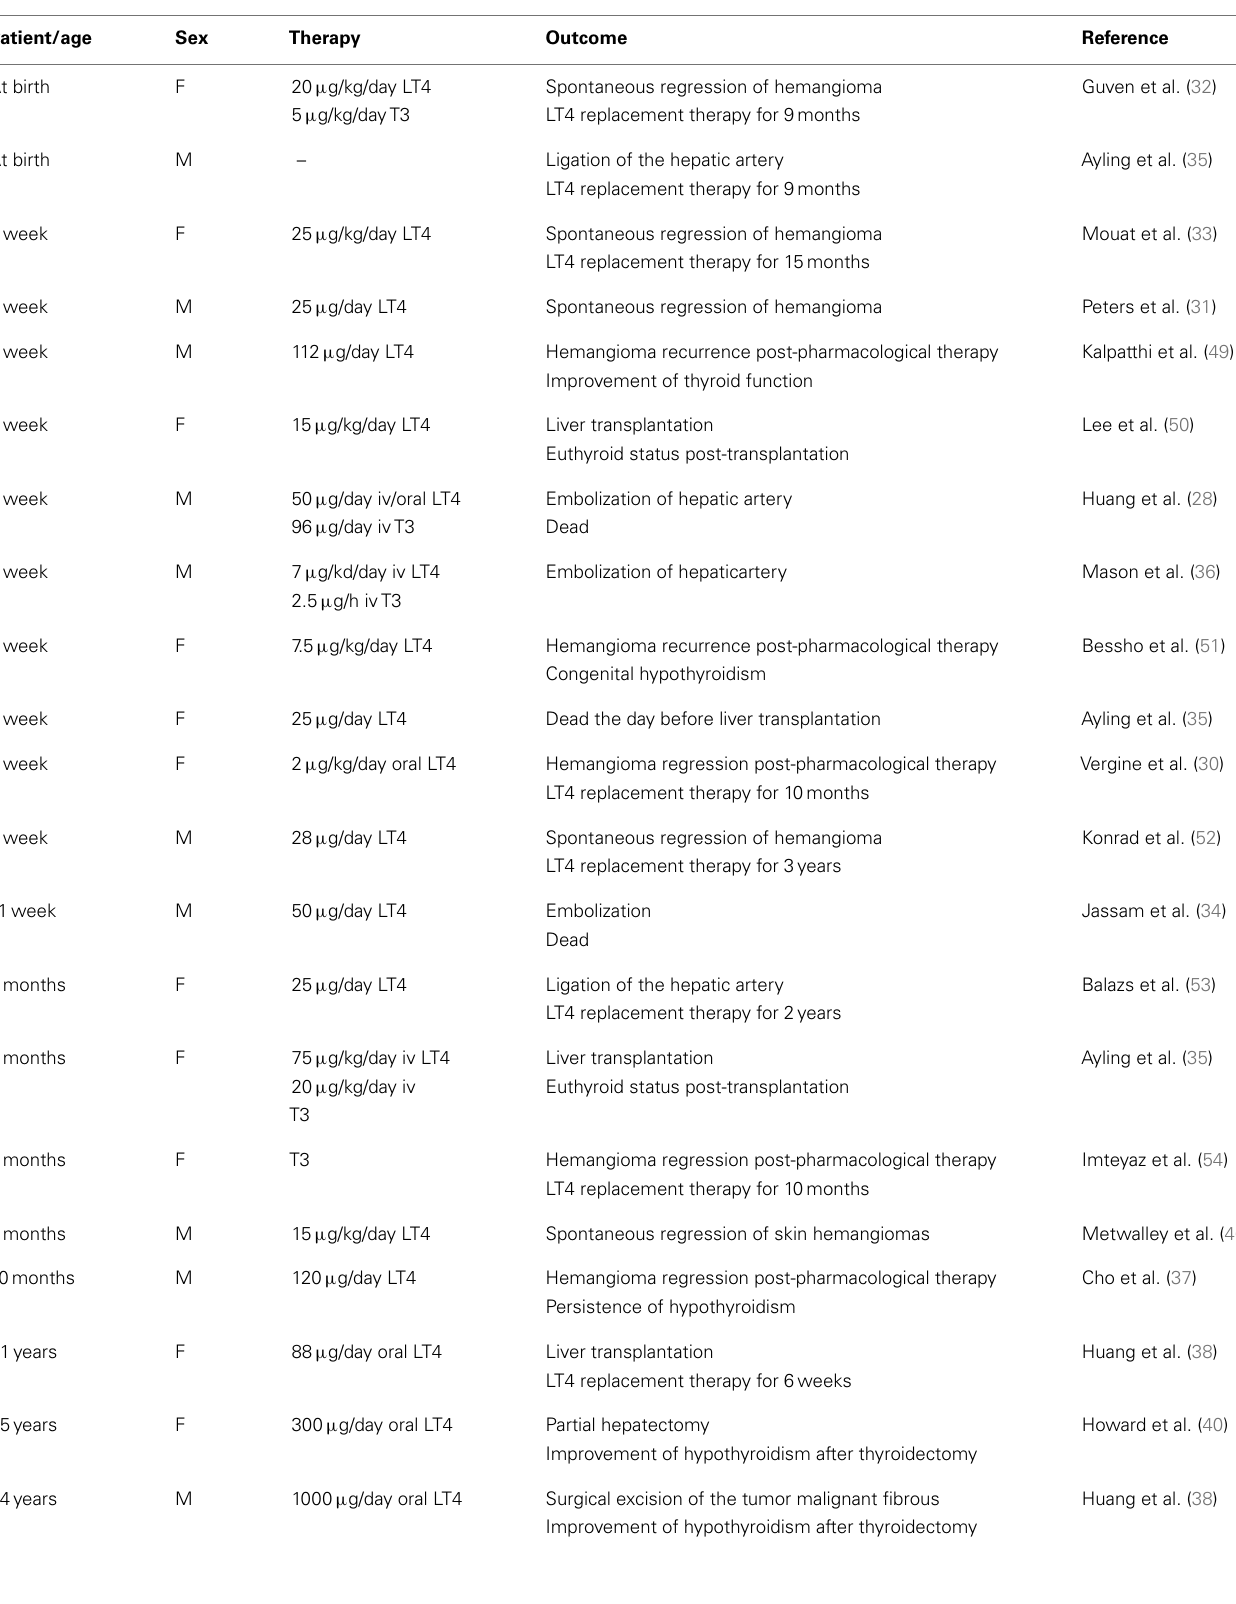
Table 1 | Summary of published cases of “consumptive